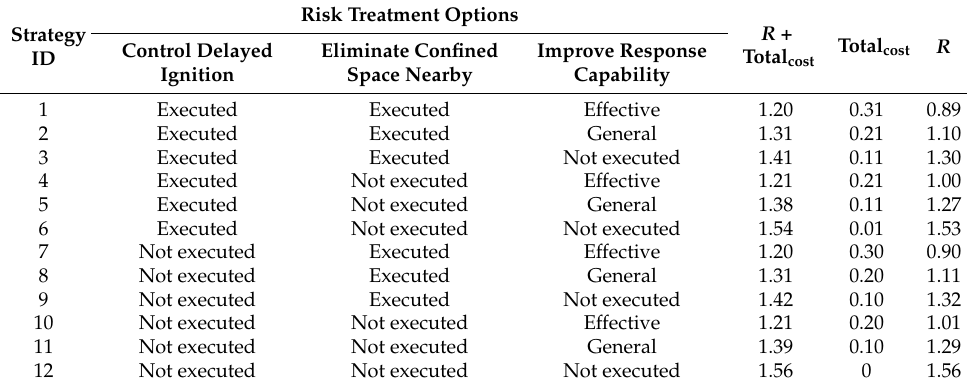
Table 4. Risk treatment options and their